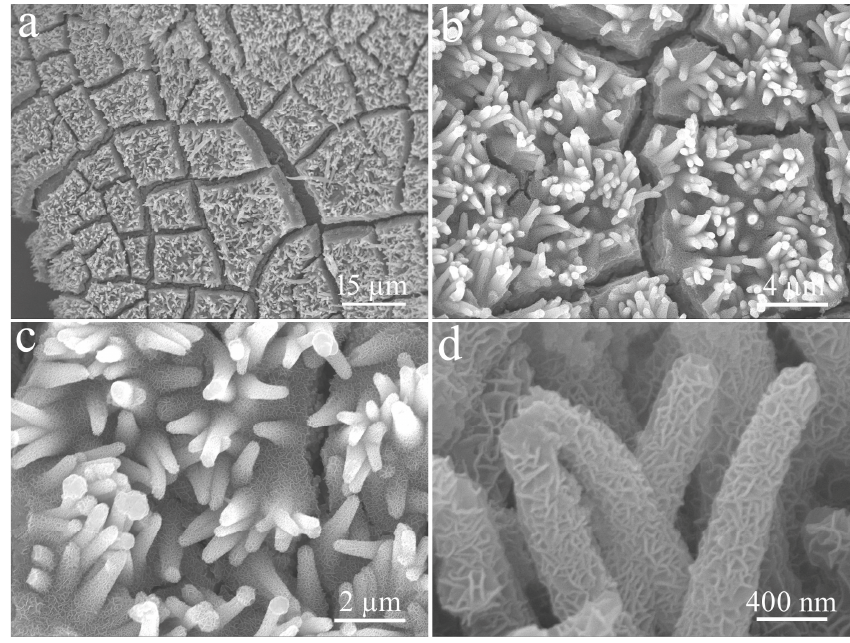
Figure 13. Low ( a , b ) and high ( c , d ) magnifification SEM images of the CuO/NCS composite after the electrochemical performance test.